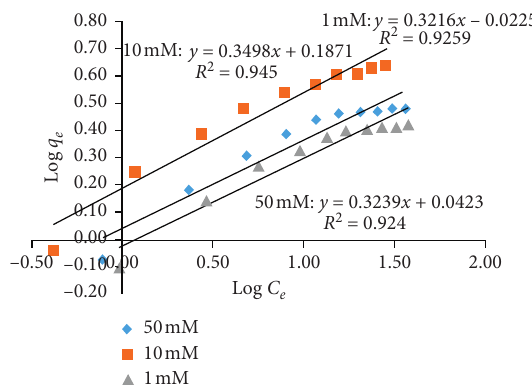
Figure 7: Adsorption isotherms of TC onto NCPML at three NaCl concentrations fitted by the Freundlich model.